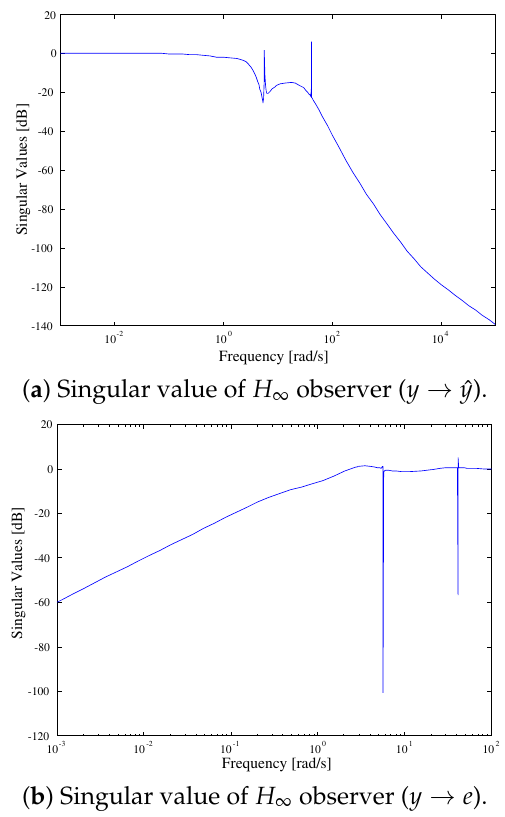
Figure 7. Singular value of H ∞